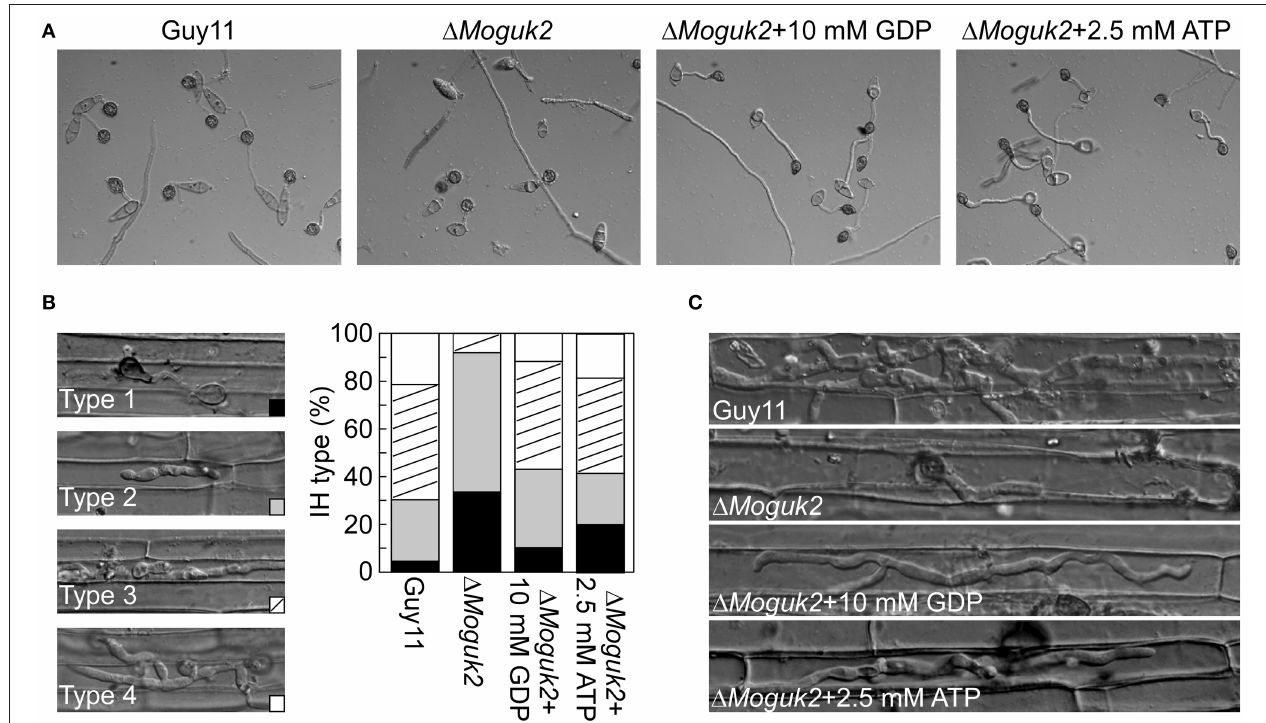
FIGURE 8 | Exogenous GDP and ATP partially restored the defects of the 1 Moguk2 mutant. (A) Appressorial formation of the 1 Moguk2 mutant with or without exogenous GDP or ATP, and photographed at 24 hpi. (B) Statistical analysis the infectious hyphae (IH) type of the 1 Moguk2 mutant in rice leaf sheath with or without exogenous GDP or ATP, and photographed at 30 hpi. (C) IH observation of the 1 Moguk2 mutant with or without exogenous GDP or ATP at 40